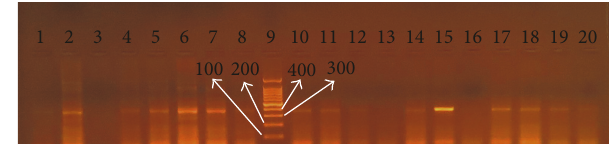
Figure 4: PCR products for H. pylori with iceA2 gene-based primers. The product size is 120 bp. Lanes 1 and 15 are ladders. Lanes 2–14 and 16–20 are patients’ biopsy